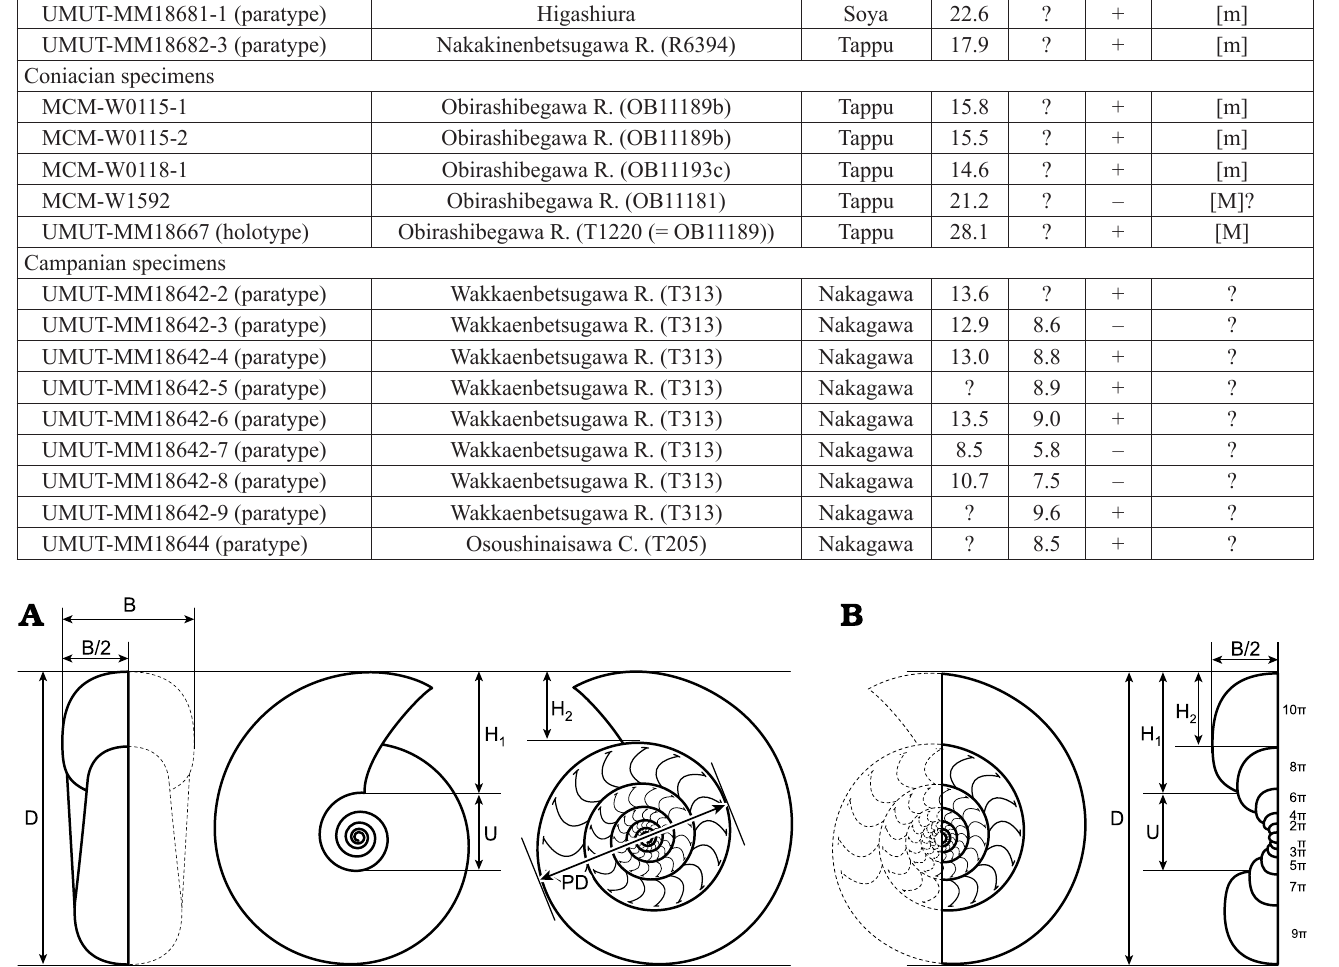
Fig. 3. Measurements of the conch geometries of tetragonitid ammonoid Tetragonites minimus Shigeta, 1989, from the Yezo Group in Hokkaido, Japan. A . Measured parameters on the specimens polished along the median plane. B . Measured ontogenetic changes of parameters on the specimens polished along the median plane, followed by the perpendicular plane. Abbreviations: B, whorl breadth; D, shell diameter; H 1 , whorl height; H 2 , ventral whorl height; PD, phragmocone diameter; U, umbilical